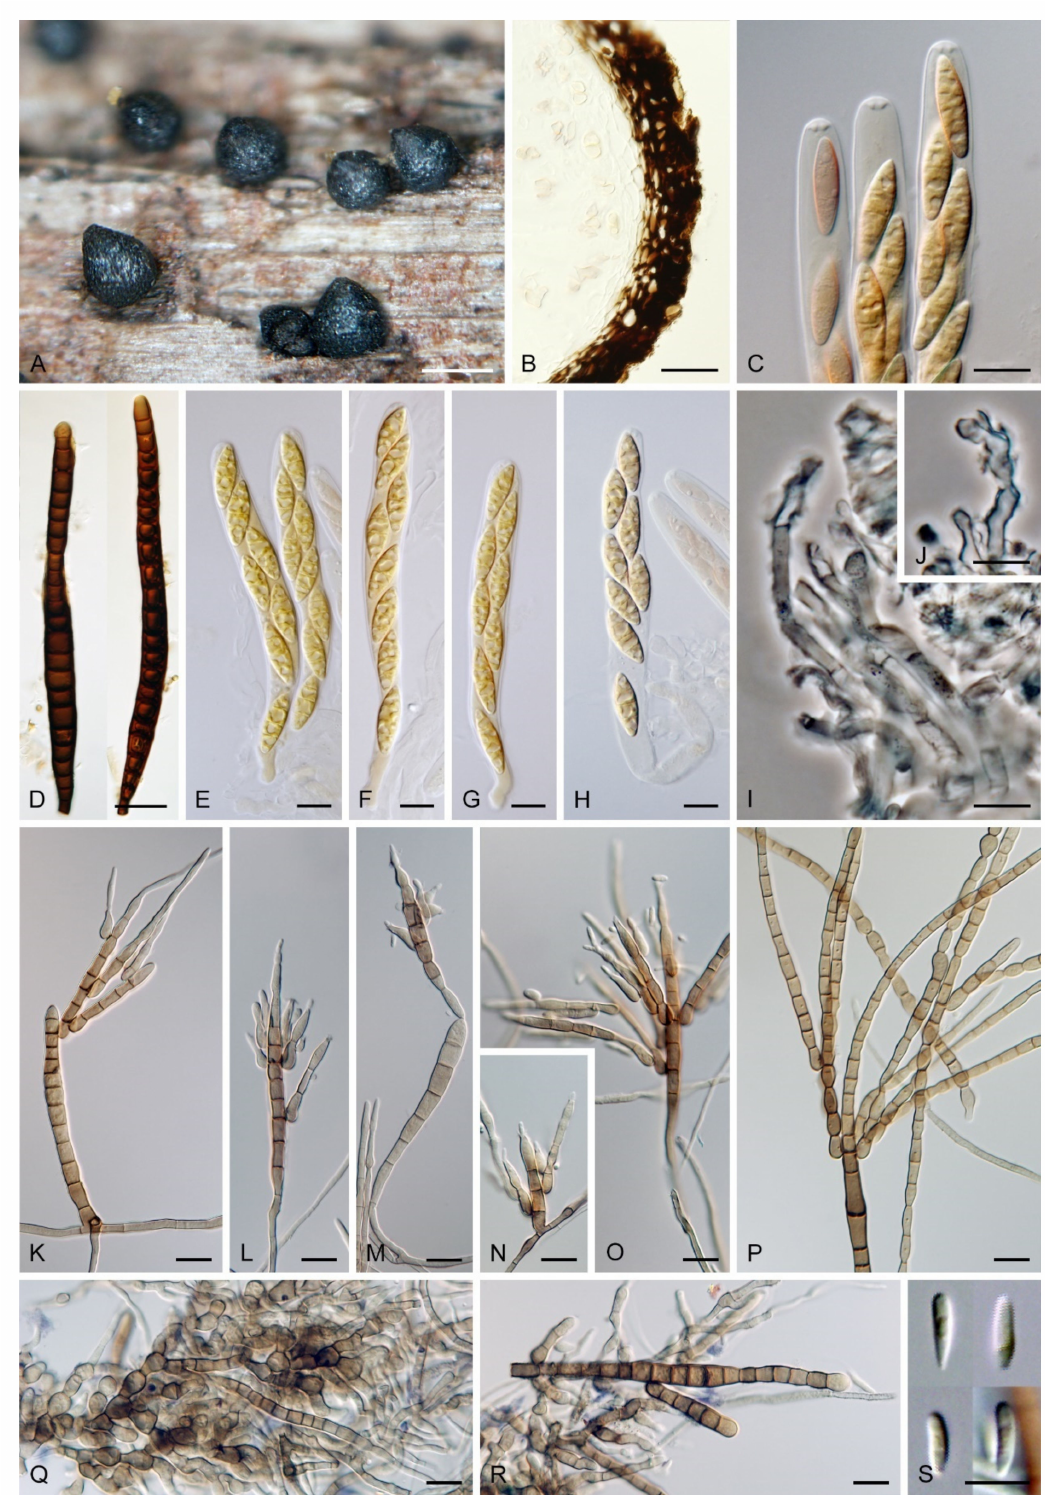
Figure 17. Zanclospora ramifera (ICMP 22738 ex-type). ( A ) Ascomata. ( B ) Vertical section of the ascomal wall. ( C ) Ascal apices with apical rings. ( D ) Stanjehughesia-like conidiophores. ( E – H ) Asci with ascospores. ( I ) Paraphyses. ( J ) Ascogenous hyphae. ( K – P ) Zanclospora conidiophores. ( Q , R ) Mycelium with stanjehughesia-like conidiophores. ( S ) Microconidia. Images: ( A – J ) on natural substrate; ( K – S ) on MLA after 8 weeks. Bars: ( A ) = 250 µ m; ( B , D ) = 20 µ m; ( C , E – R ) = 10 µ m; ( S ) = 5 µ